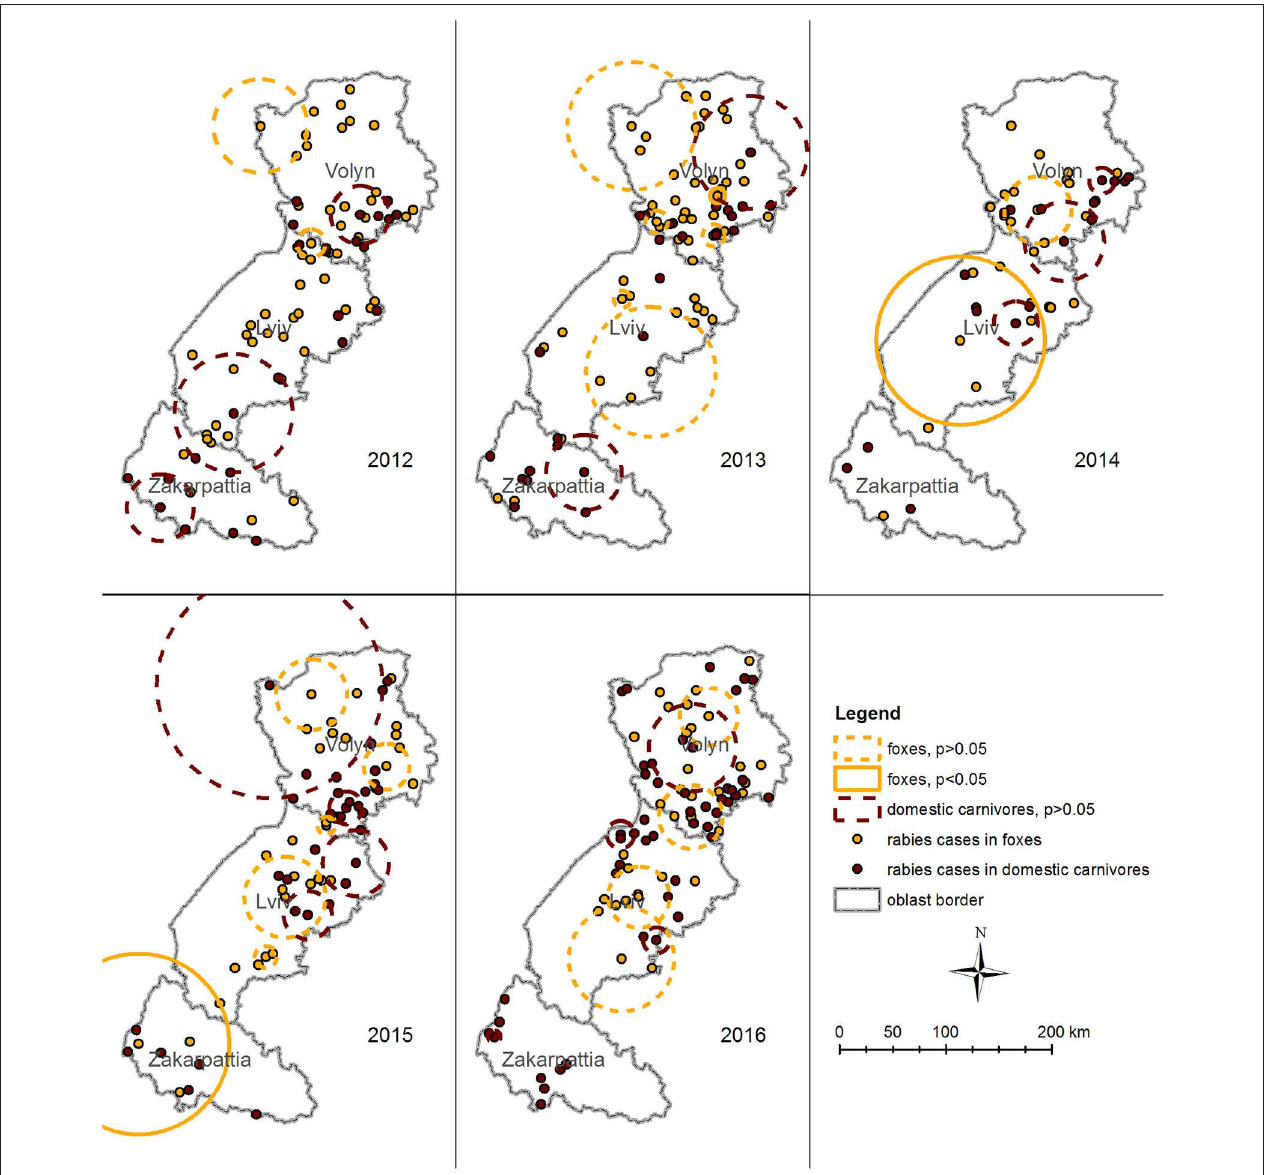
FIGURE 7 | Spatiotemporal clustering of rabies cases in foxes (orange circles) and domestic carnivores (brown circles) in Volyn, Lviv, and Zakarpattia oblasts from 2012 to 2016 detected using space–time permutation model in SatScan. Solid circles represent clusters with p < 0.05. Dashed circles represent clusters with p > 0.05. Space–time permutation model for rabies cases in domestic carnivores did not detect a significant cluster. Significant clusters of rabies cases in foxes were detected for years 2013, 2014, and 2015. Although some of them overlap with insignificant clusters in domestic carnivores in space, none of them intersect in